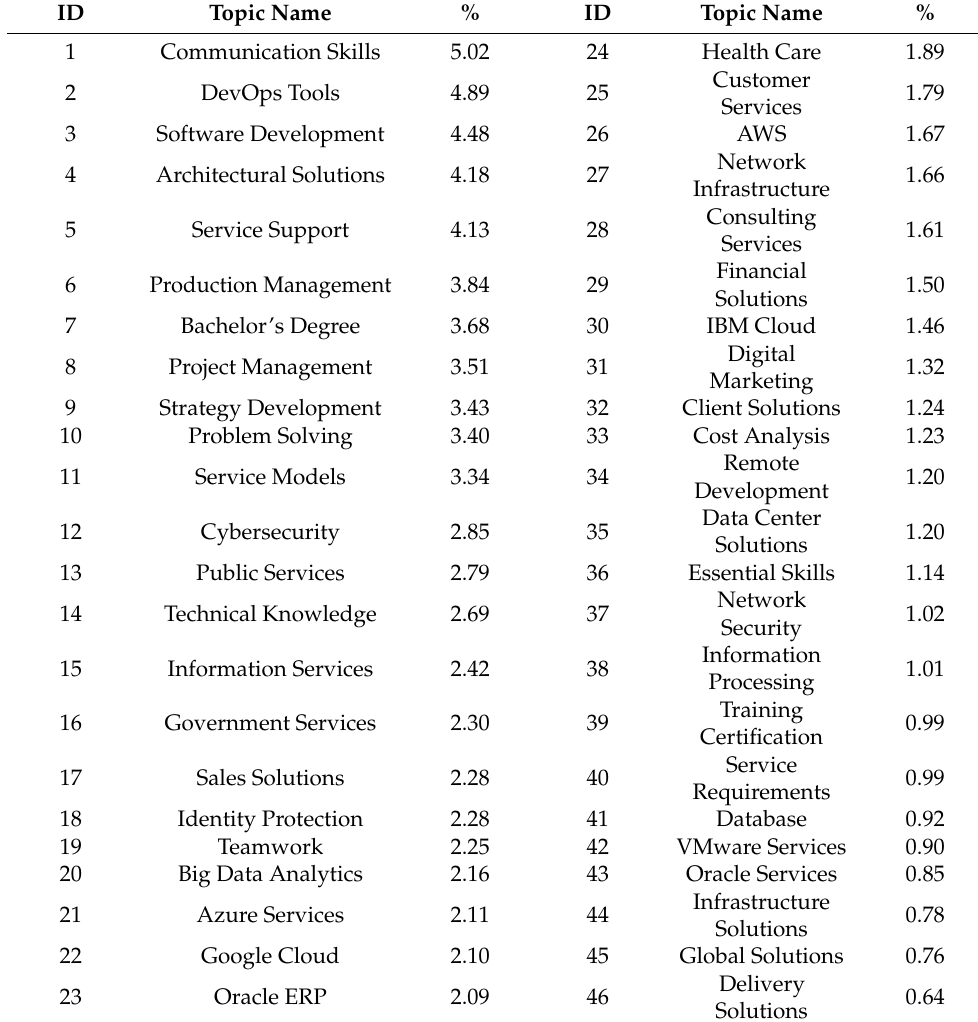
Table 2. Topics (skills) discovered by LDA.